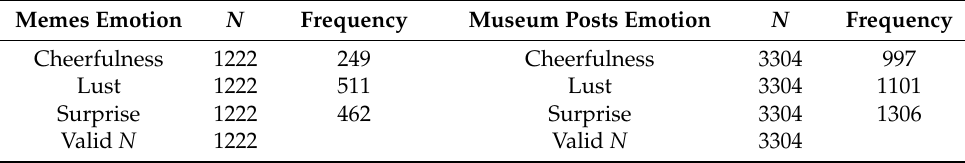
Table 2. The frequency of three emotions on the Artistic memes dataset and Museum posts dataset. Memes